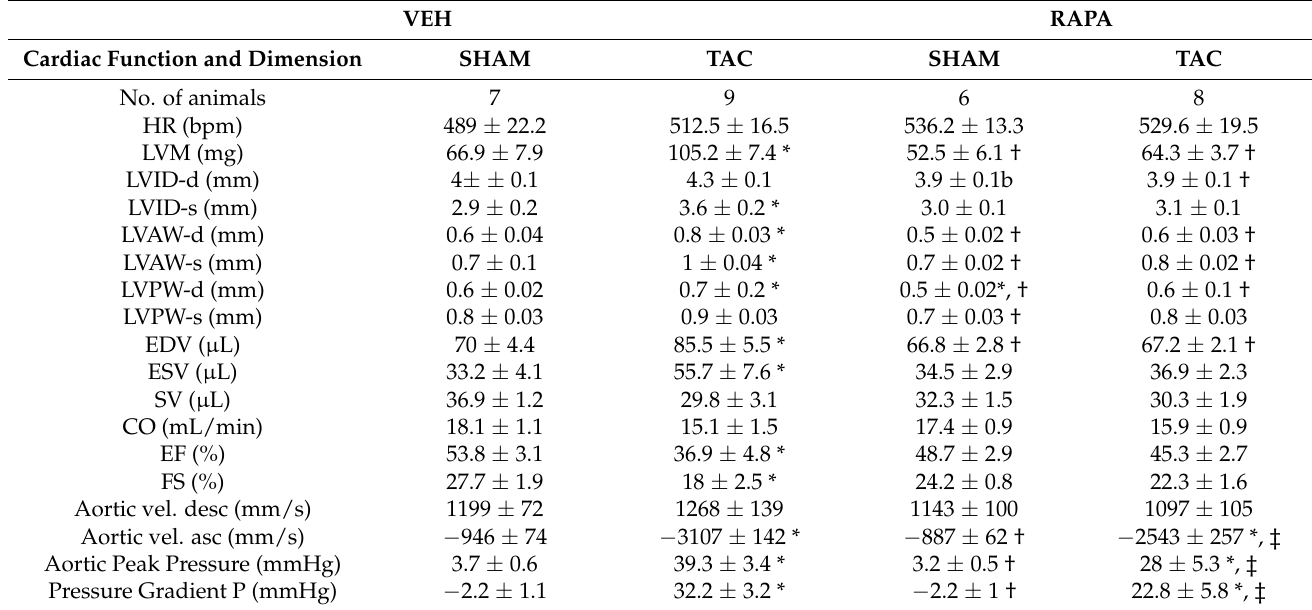
Table 1. Echocardiography 10 weeks after intervention of heart failure